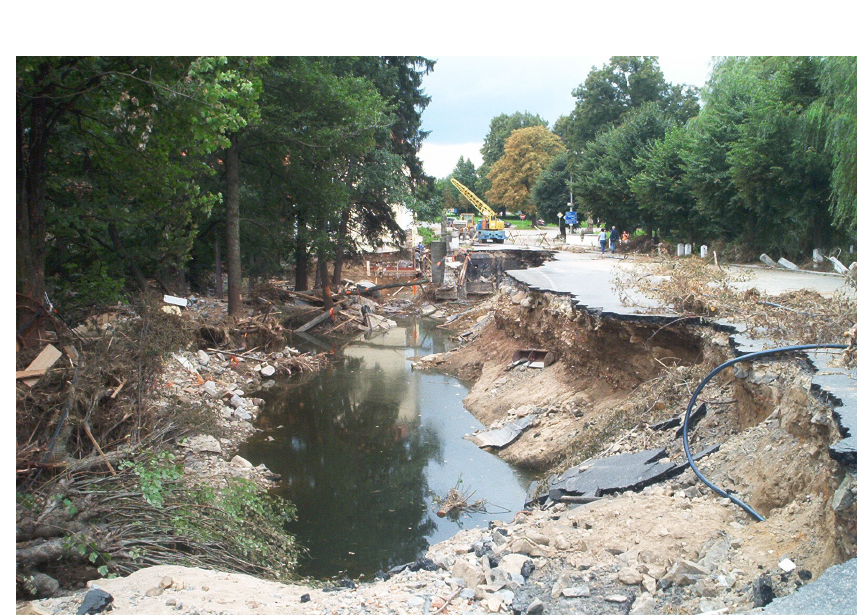
Figure 2. Example of disturbance of the downstream slope and crest of a dam which is used as an important communication line – E 49.